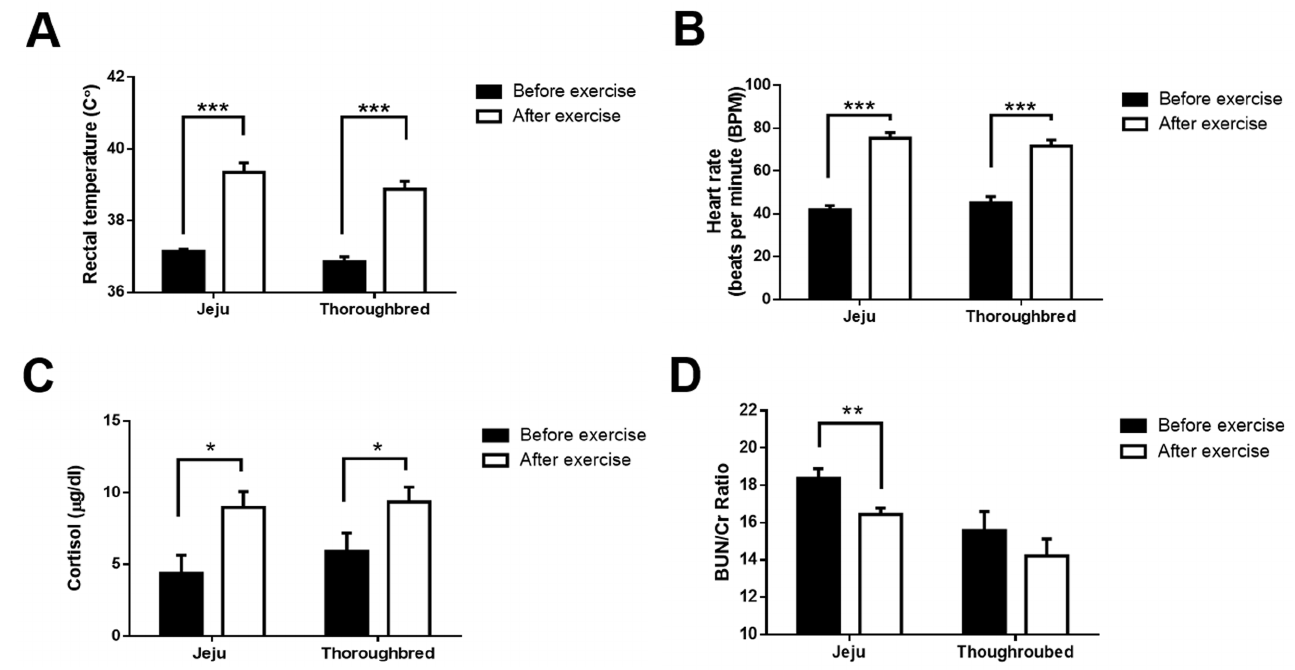
Figure 1. Jeju horses showing significantly increased muscle catabolism-related metabolic parameters after 30 min of exercise. Jeju and Thoroughbred horses were exercised for 30 min. Rectal temperatures were measured, and blood samples were collected for each horse both before and after exercise. (A) Rectal temperature; (B) heart rate; and (C) cortisol levels of Jeju and Thoroughbred horses before and after exercise. (D) Blood urea nitrogen (BUN) and creatinine (Cr) levels in blood samples. The BUN/Cr ratio was calculated to compare the muscle catabolism of the two breeds. Black and white circles are used to represent data from before and after exercise, respectively (n = 5 for each breed; * p<0.05, ** p<0.01, and *** p<0.001, unpaired Student’s